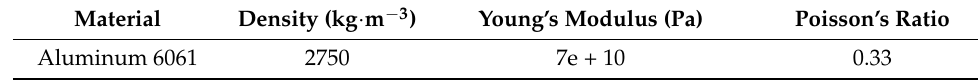
Table 1. Material properties of 6061 aluminum.